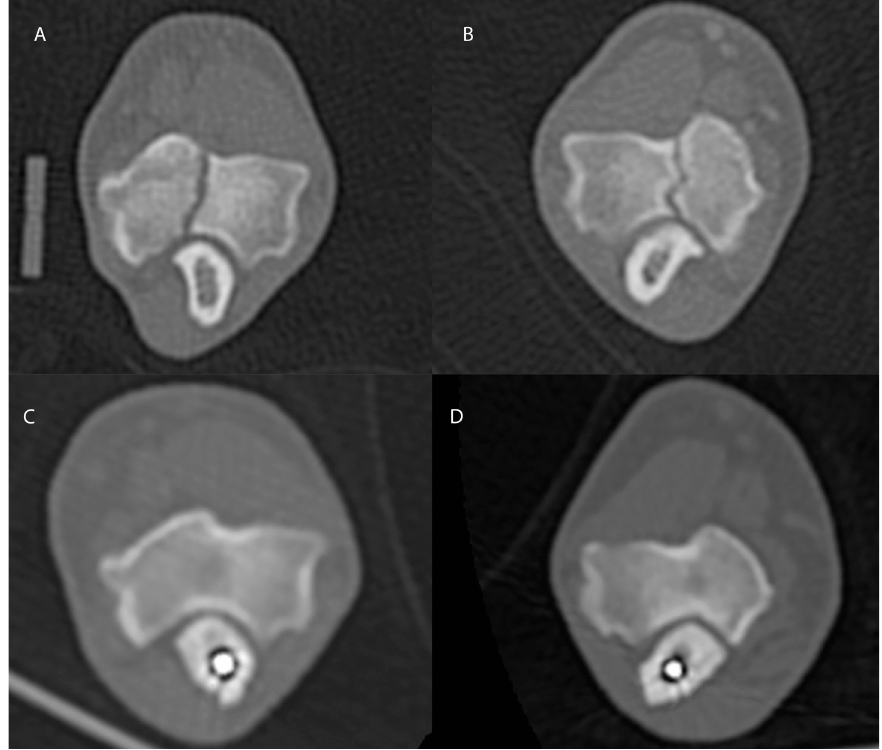
Figure 3. Coronal computed tomographic images of the left ( A , C ) and right ( B , D ) elbows. An obvious hypoattenuating line is present in the pre-operative images ( A , B ) representing a complete humeral intracondylar fissure extending from the caudal to the cranial articular surfaces. The fissures appear to have completely resolved in the CT images obtained 8 months after surgery ( C , D